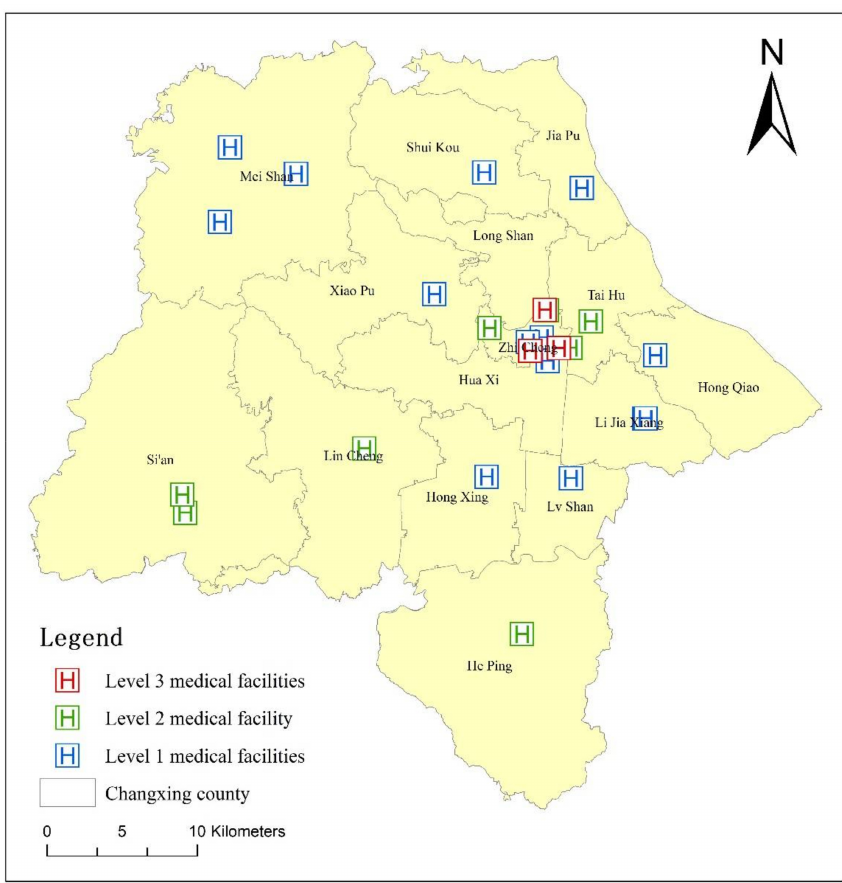
Figure 4. Three levels of medical facility layouts in Changxing in the current